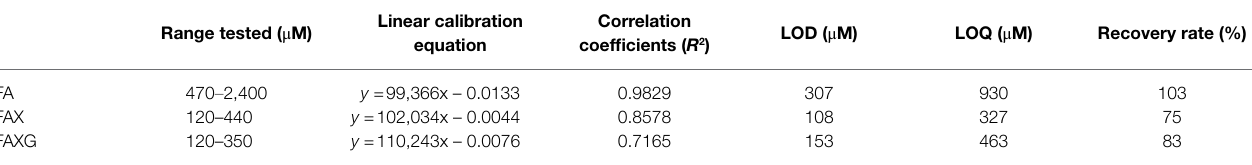
TABLE 2 | Calibration equations a , correlation coefficients, limits of detection (LOD), limits of quantification (LOQ), and recovery rates for FA, FAX, and FAXG using HSQC-NMR detection.